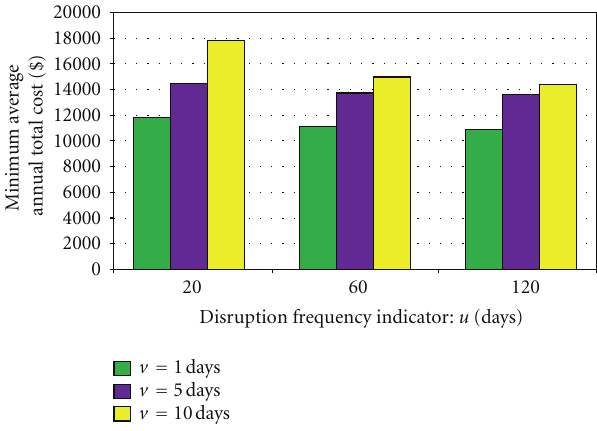
Figure 7: The impact of v on ATC under di ff erent scenarios of u .